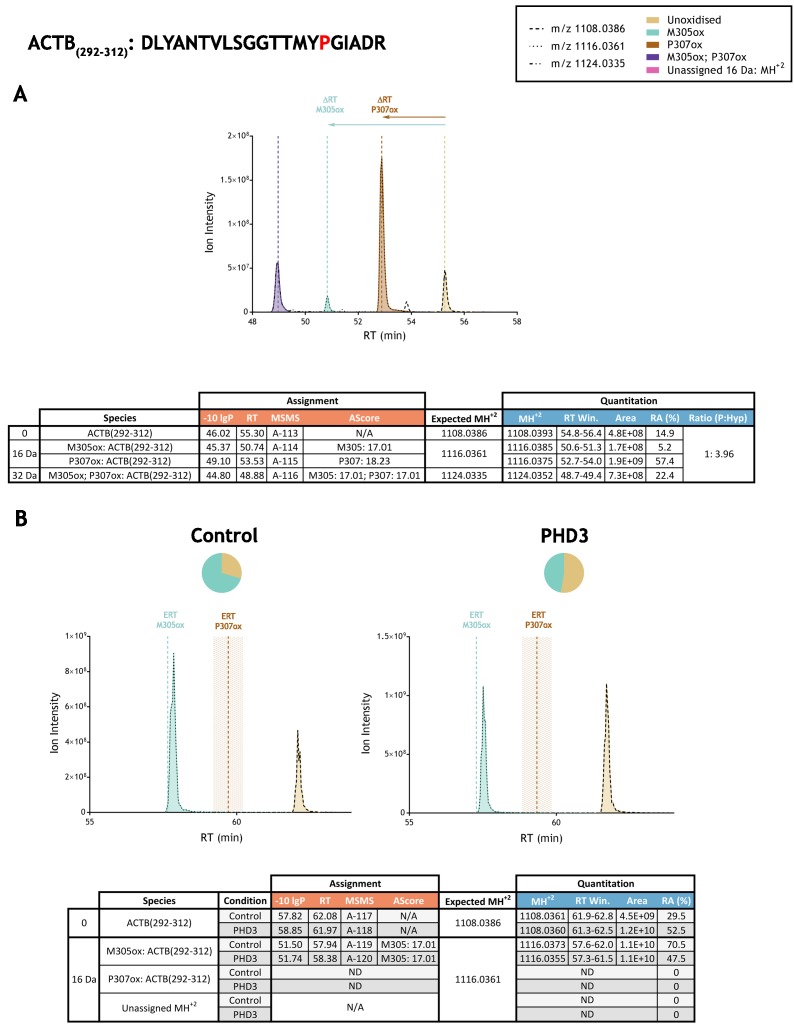
Quantitation of peptide oxidation on ACTB(292-312) following reaction of full-length beta-actin with recombinant PHD3.XIC data presented in (A) shows ion intensity and retention time (RT) characteristics of equimolar synthetic peptide standards for unoxidised and P307ox forms of the ACTB(292-312) peptide. MSMS assigned species are coloured (see inset) and include non-enzymatic methionine oxidation (M305ox; turquoise); vertical dashed lines define peak maxima used to derive ΔRT values for M305ox and P307ox. Note, comparative ion counts were 4-fold higher for P307ox (brown) relative to the unoxidised peptide (light brown). Panel (B) shows comparable XIC data for protease-digested IVTT substrate under control (left) or PHD3-reacted (right) conditions. Peaks corresponding to unoxidised and M305ox forms of ACTB(292-312) were assigned by MSMS (see inset for colour code); P307ox was not detected. Estimated RT (ERT) values for oxidised peptides, derived from (A), are indicated by dashed vertical lines, shading applied to ERT P307ox corresponds to a 1 min RT window. Unassigned ions of compatible mass over charge for hydroxylation were not observed across the elution window. Quantitative data for observed species are presented as pie charts with XIC data. Assignment and quantitation data are tabulated below each panel, table headers are as follows: (−10lgP) significance score of leading assignment at given (RT) with ambiguity score (AScore) for PTM localisation and reference to primary MSMS data in Supplementary file 1. Quantitative data reports ion counts (Area) of observed masses (MH+2) integrated over time (RT Win.), expressed as relative abundance (RA). Data on detection efficiency for synthetic peptides (Panel A, P: Hyp) is an aggregated ratio of prolyl (P) to hydroxyprolyl (Hyp) containing species.